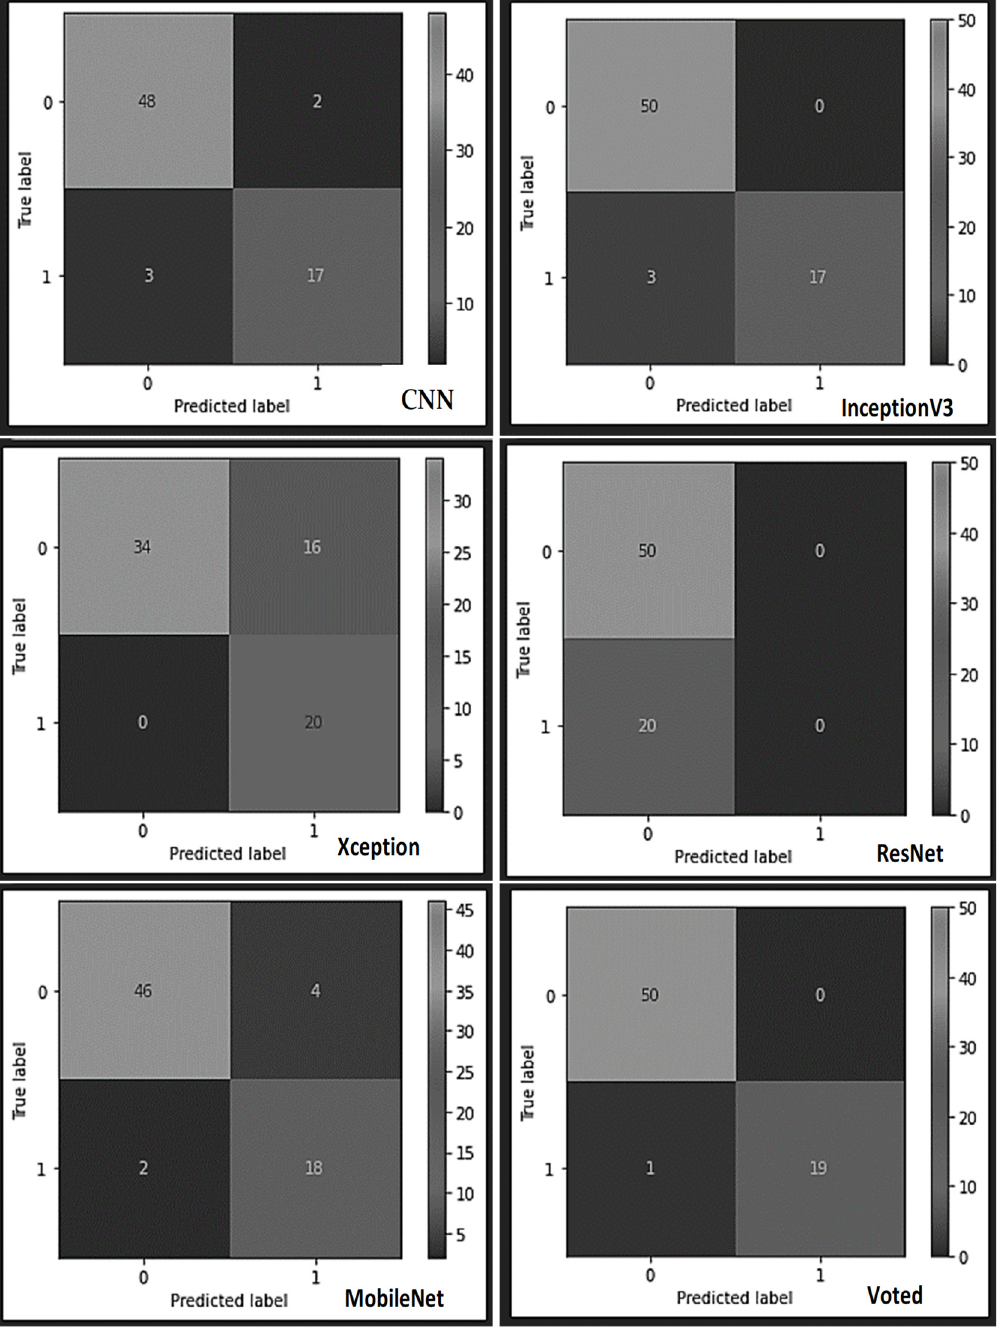
Figure 4. The various confusion matrices obtained from each learner using the industrial AC Piston dataset.